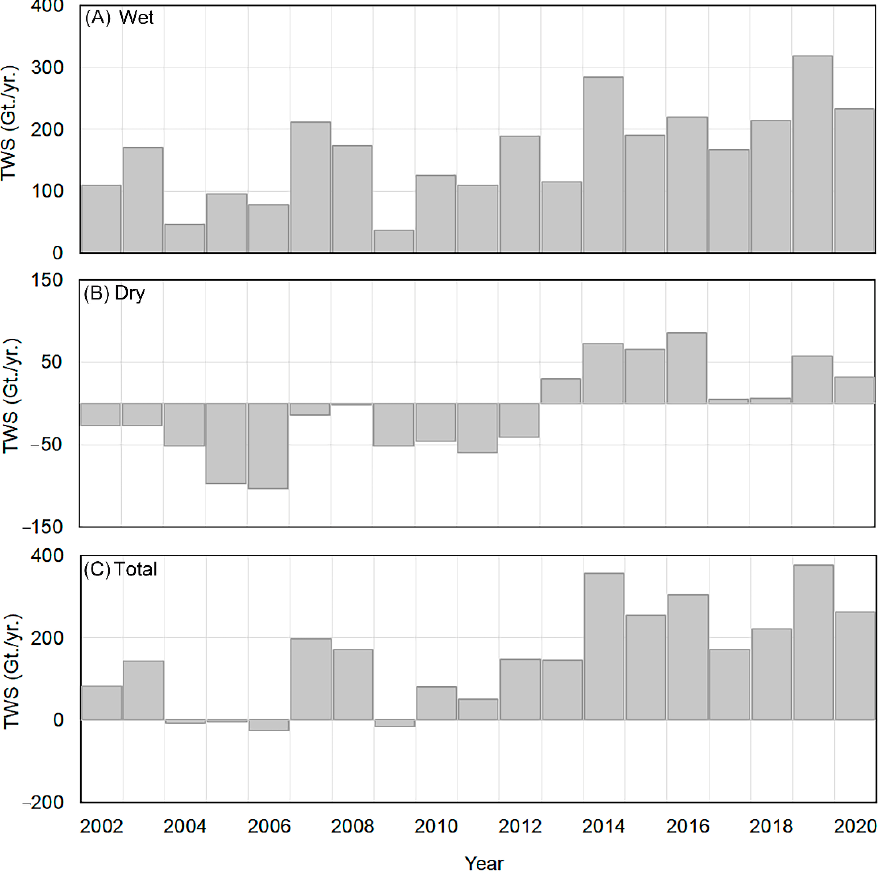
Figure 4 . The total changes in TWS over NRB from 2002–2020 during the wet ( A ) and dry ( B ) seasons, plot ( C ) shows the total water storage during the two seasons.